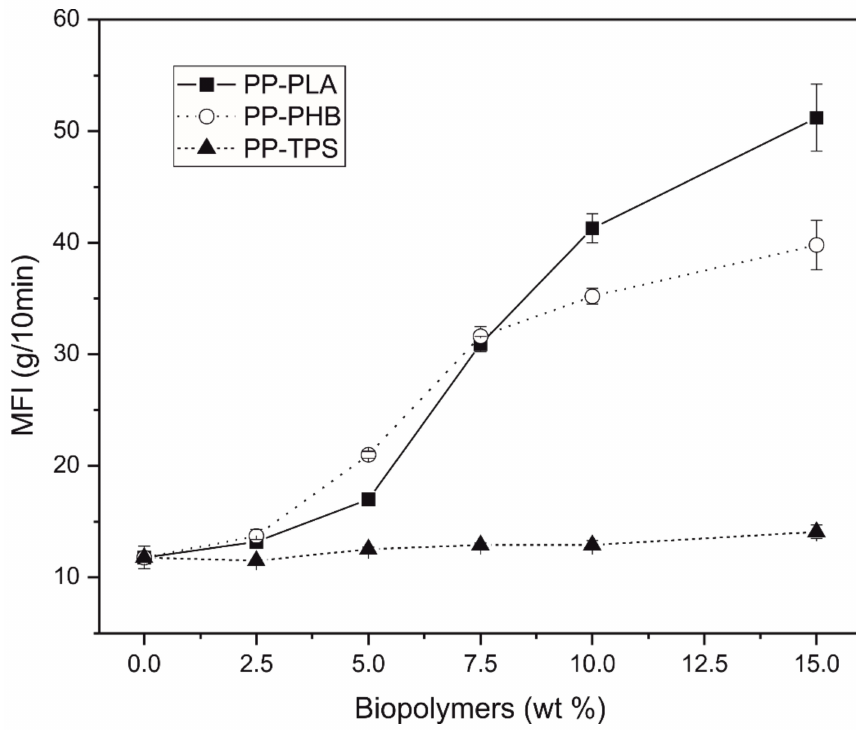
Figure 5. Plot of MFI vs. wt.% biodegradable